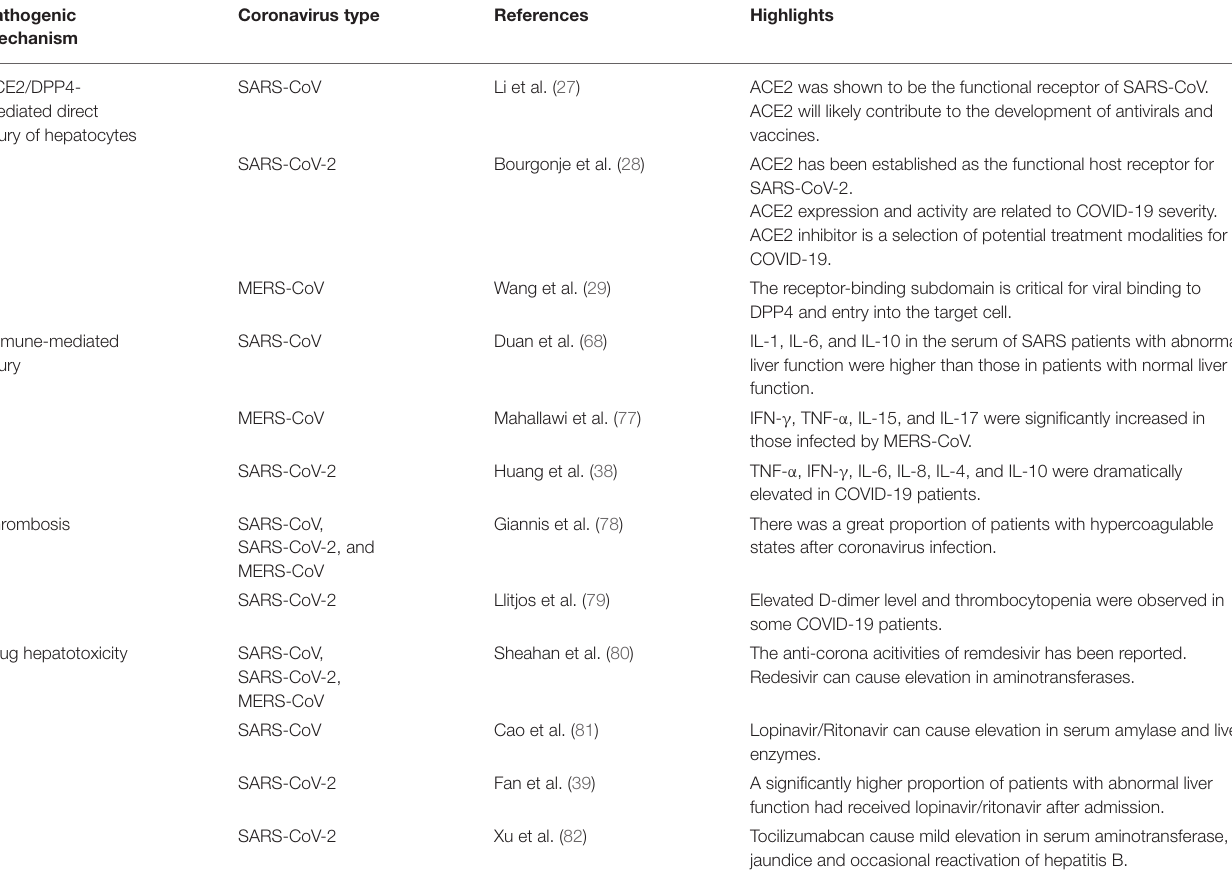
TABLE 2 | The mechanisms of coronavirus-induced liver